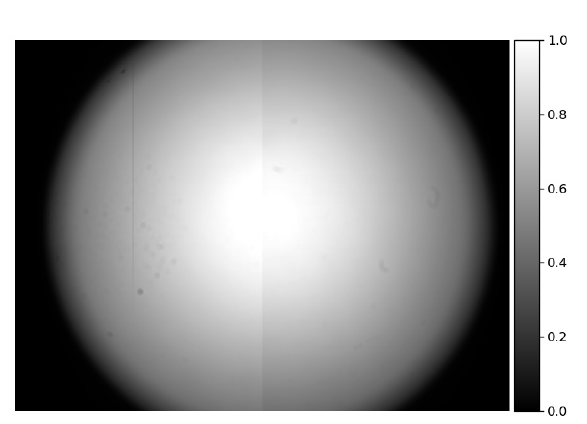
Figure 14. Spatial factor map obtained by the flat-field calibration.